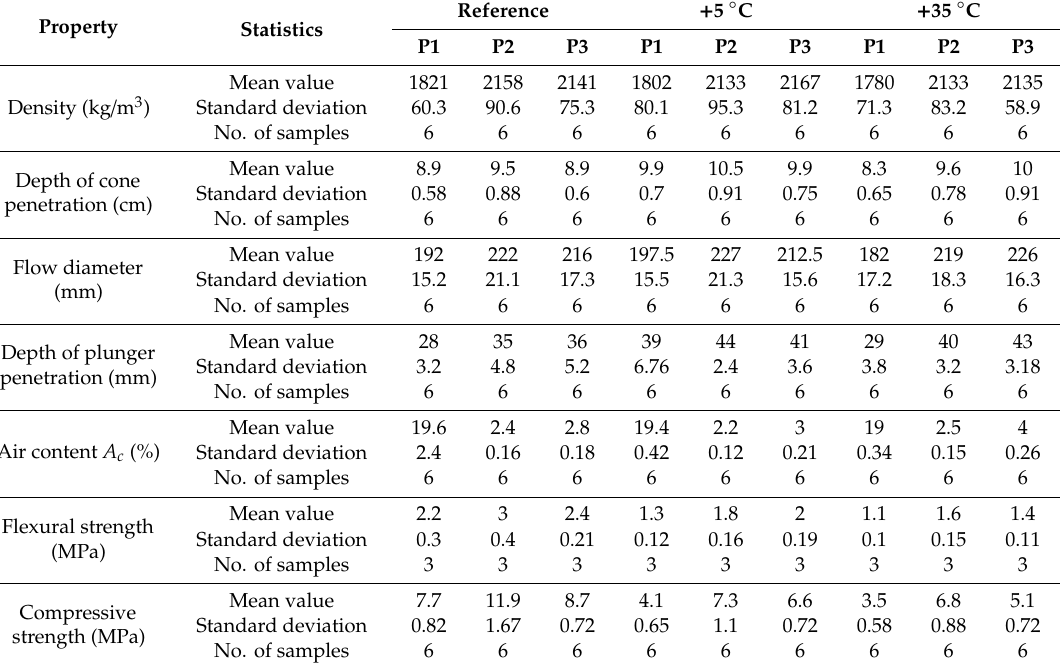
Table 21. Results of tests of the influence of temperature on properties of plaster.